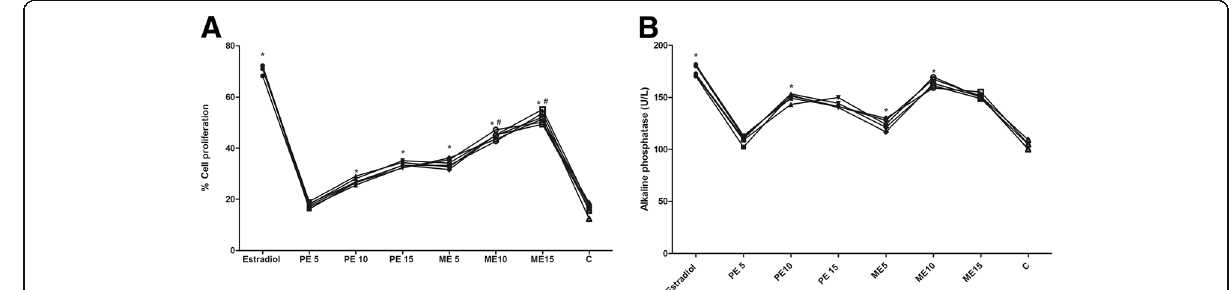
Fig. 3 The effects of B. cieba on osteoblast-like UMR106 lines ( a ) Cell proliferation ( b ) ALP activity. Results: mean ± SD, analyzed by one-way ANOVA followed by Bonferroni ’ s multiple comparison tests; a p < 0.05 vs. Sham; b p < 0.05 vs. OVX; c p > 0.05 vs. Std